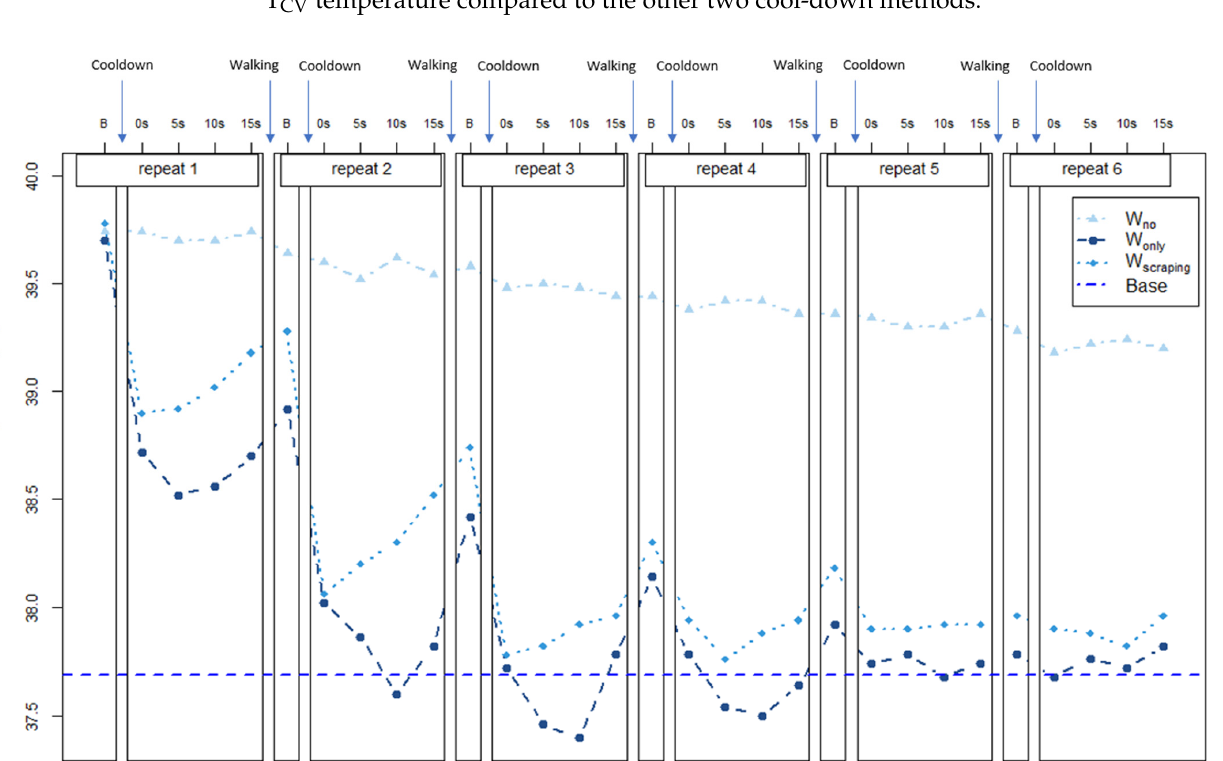
Figure 5. Central venous temperature changes before and immediately after (0–15 s) cold water application during the cool-down phase. Each repeat of cold water application (repeat 1~6) consisted of five-time points, before cold water application (B), immediately after cold water application (0 s), and 5, 10, and 15 s after the time point (5 s–15 s). In between the repeats, the horses were walked in an undercover area until the next repeat resumed. Abbreviations: W no = no water application (continuously walking), W only = water application, W scraping = water application following scraping, Base = average temperature before treadmill exercise.